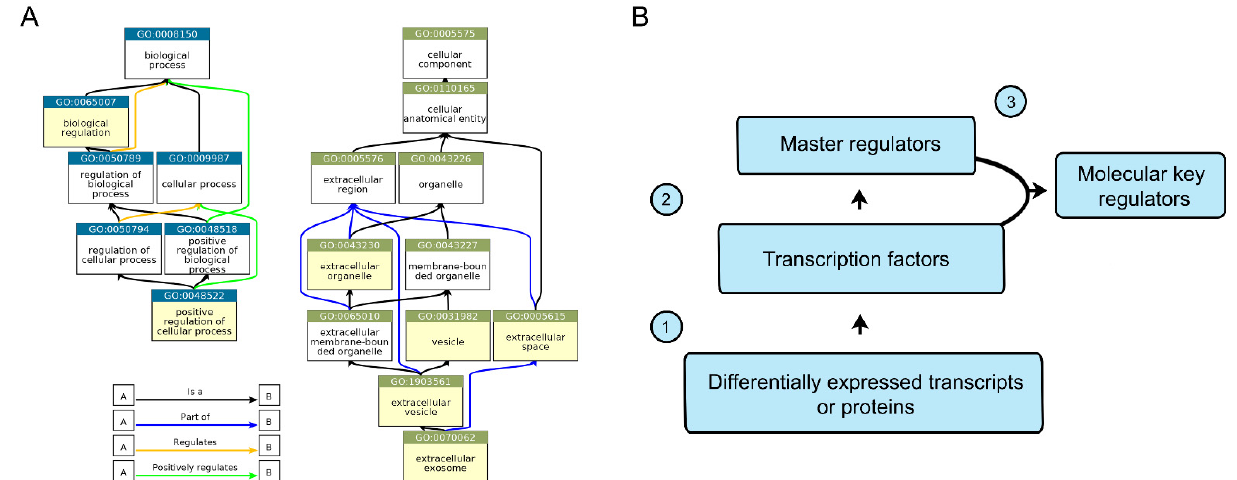
Figure 3. Gene Ontology classification of differentially expressed genes and the algorithm of in silico analysis of CD133 molecular key regulators. ( A ) Terms of GO classification shared by all lists of differentially expressed transcripts and proteins are highlighted in yellow. The charts were created by QuickGO browser (ebi.ac.uk/QuickGO). ( B ) Algorithm of the in silico analysis was performed by GeneXplain platform. The lists of transcriptional factors (TFs) were generated based on the lists of differentially expressed transcripts or proteins (1). The lists of master regulators (MRs) were based on the TFs lists (2). The list of key regulators was generated based on the intersection between TFs and MRs lists (3).